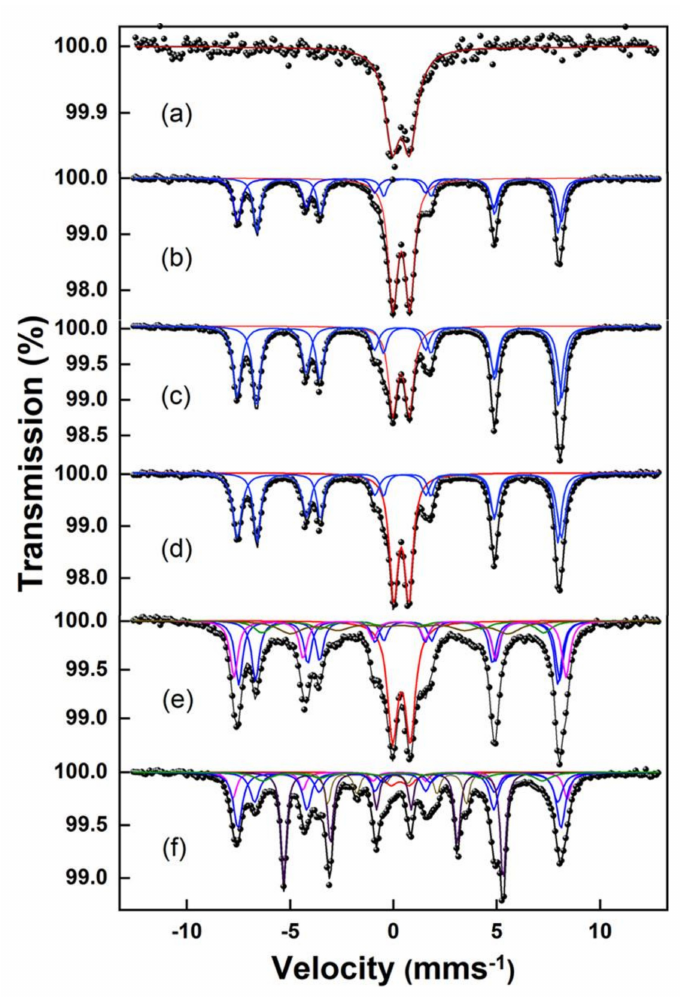
Figure 9. Room-temperature Mössbauer spectra of activated carbons at di ff erent activation temperatures ( a ) 220, ( b ) 400, ( c ) 500, ( d ) 600, ( e ) 700, and ( f ) 800 ◦ C (reprinted from [69] with the permission of